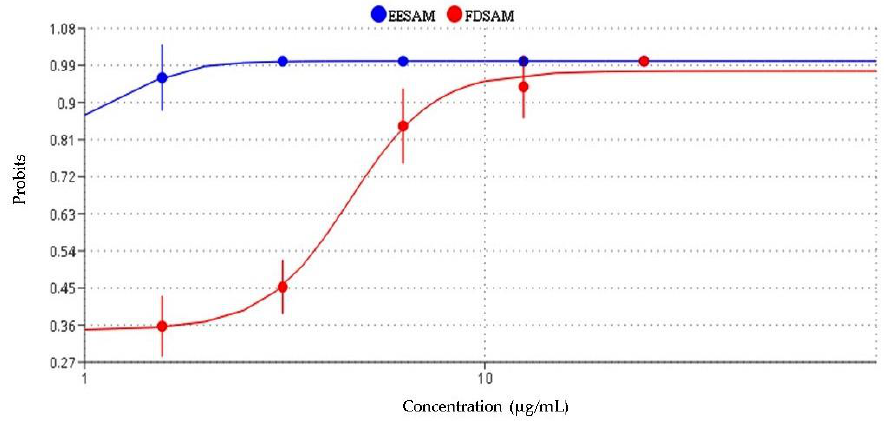
Figure 7. Determination of lethal dose in A. salina larvae. Source: Authors.